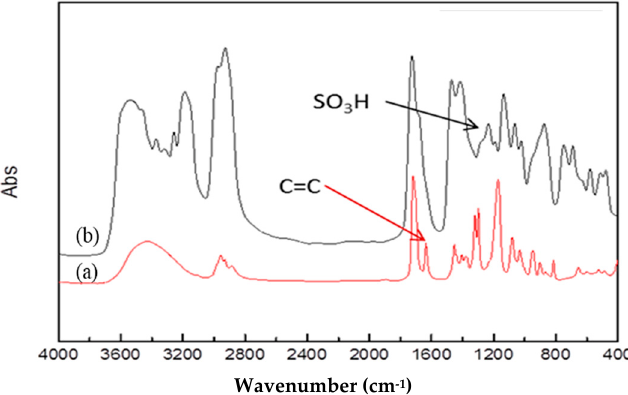
Figure 9. Reaction scheme of the HS-SO 3 H cross-linked membrane.